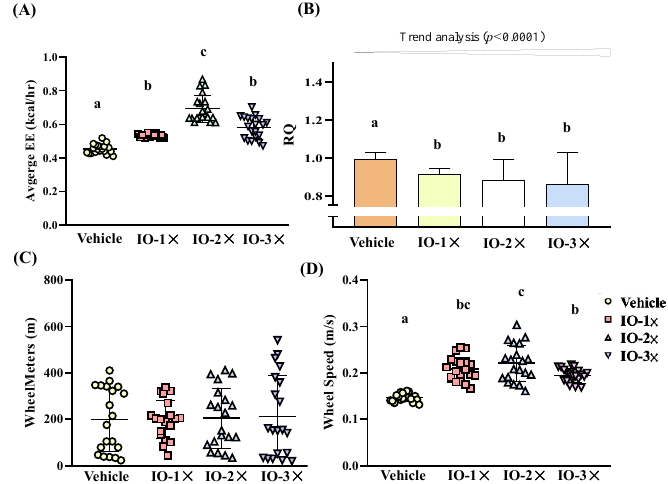
Figure 6. Effect of IO supplementation on energy metabolism and in-cage spontaneous physical activity ( A ) Average energy expenditure, ( B ) Respiratory quotient, ( C ) Distance of spontaneous exercise, ( D ) Wheel speed of spontaneous exercise. Mice were pretreated with the vehicle, IO-1 × , IO-2 × , and IO-3 × for 6 wk. They were measured using respirometric indirect calorimetry over 72 h during the IO or vehicle infusions. Data represent the mean ± SD of eight mice in each group. One-way ANOVA was used for the analysis. Different letters (a, b, c) indicate a significant difference at p < 0.05.